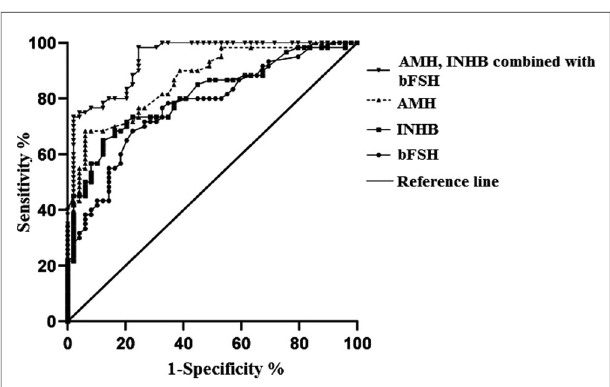
FIGURE 2 | The diagnostic value of serum AMH, INHB combined with bFSH on postoperative ovarian reserve.